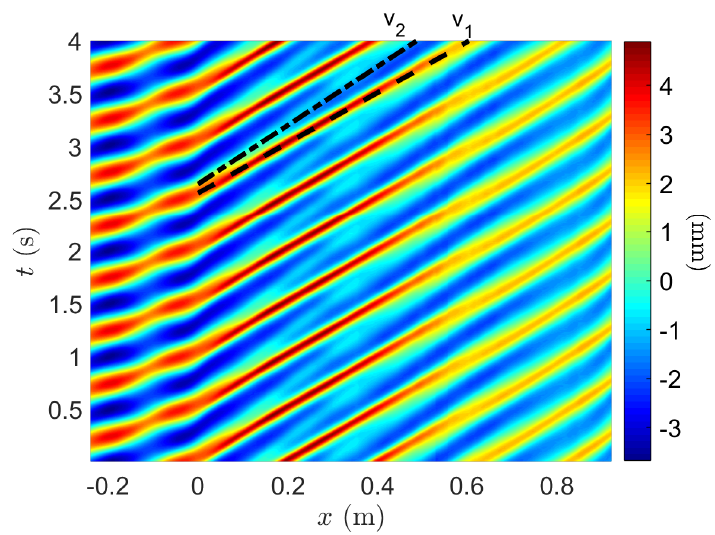
Figure 11. Space-time representation of the wave propagation at ω = 4 π s − 1 after transverse average in the y direction. Dashed and dashed-dotted lines shows two different celerities in the shallow water